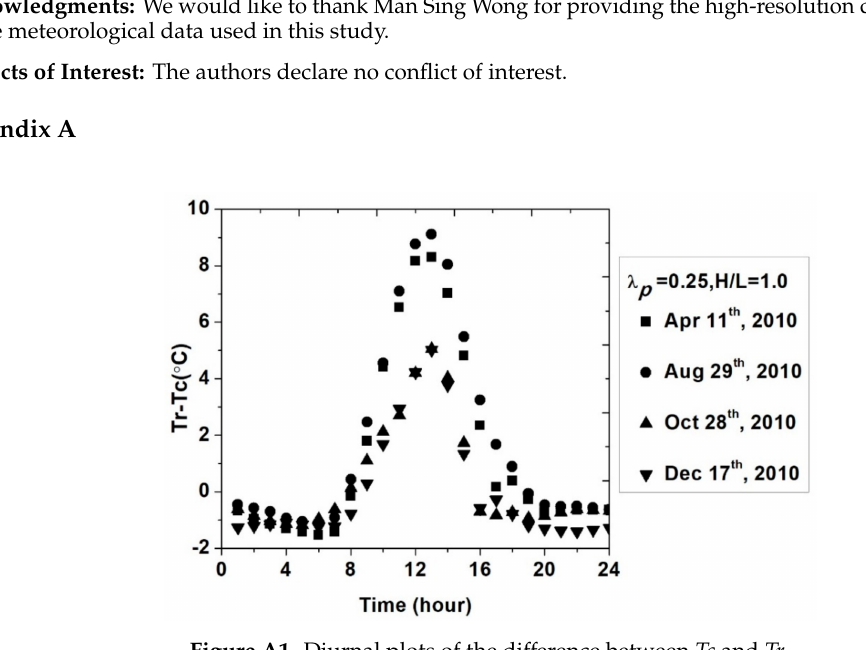
Figure A1. Diurnal plots of the di ff erence between Tc and Tr .